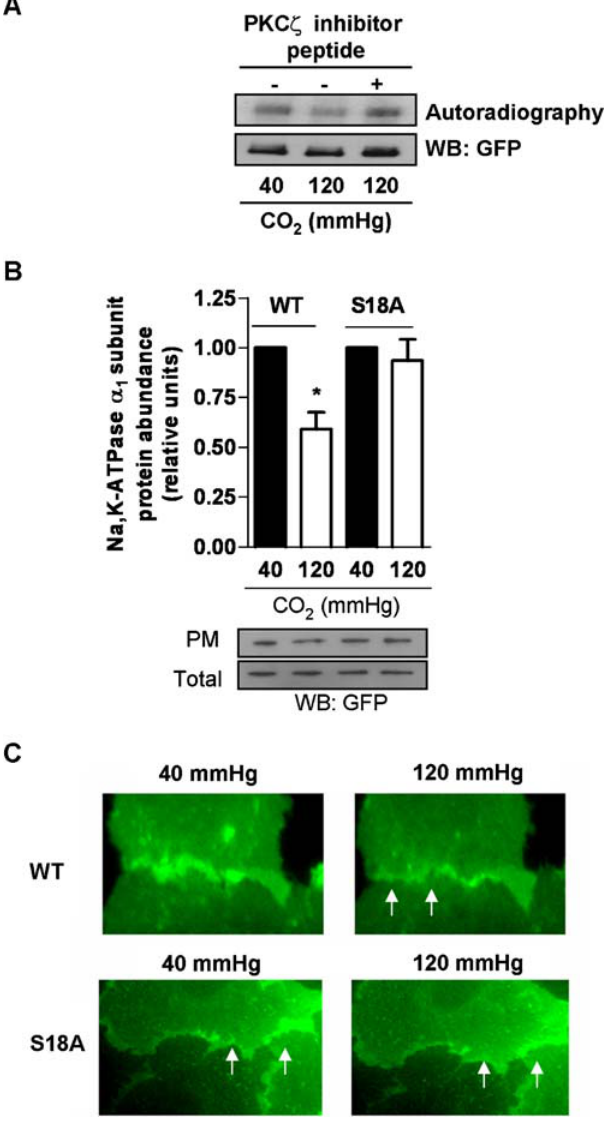
Figure 6. PKC f phosphorylates the Na,K-ATPase a 1 -subunit at Ser 18. (A) In vitro ‘‘back phosphorylation’’ assay was performed (as described in the methods section) on the immunoprecipitated Na,K-ATPase a 1 - subunit from GFP a 1-A549 cells exposed to 40 or 120 mmHg CO 2 (pH e : 7.4) for 10 min in the presence or absence of PKC f inhibitory peptide (0.1 m M, 1 h). Upper panel shows a representative autoradiography. Lower panel depicts a representative Western blot (n=3; p , 0.05 when comparing 40 mmHg vs 120 mmHg). (B) A549 cells expressing the rat GFP a 1 -subunit Na,K-ATPase (WT) or the rat GFP-S18A a 1 -subunit (S18A) were exposed to 40 or 120 mmHg CO 2 (pH e : 7.4) for 30 min. The Na,K- ATPase protein abundance at the plasma membrane (PM) was determined by biotin-streptavidin pull down and subsequent Western blot. Graph represents the mean 6 SEM, (n=5). Representative blots of Na,K-ATPase a 1 -subunit at the PM and total protein abundance are shown. (C) Live cell imaging of A549 cells expressing the rat GFP a 1 - subunit Na,K-ATPase (WT) or the rat GFP-S18A a 1 -subunit (S18A). Cells were exposed to 40 mmHg CO 2 (pH e : 7.4) for 10 min (left panels) and then switched to 120 mmHg CO 2 (pH e : 7.4) for 30 min (right panels). White arrows indicate the plasma membrane Na,K-ATPase. * p , 0.05.